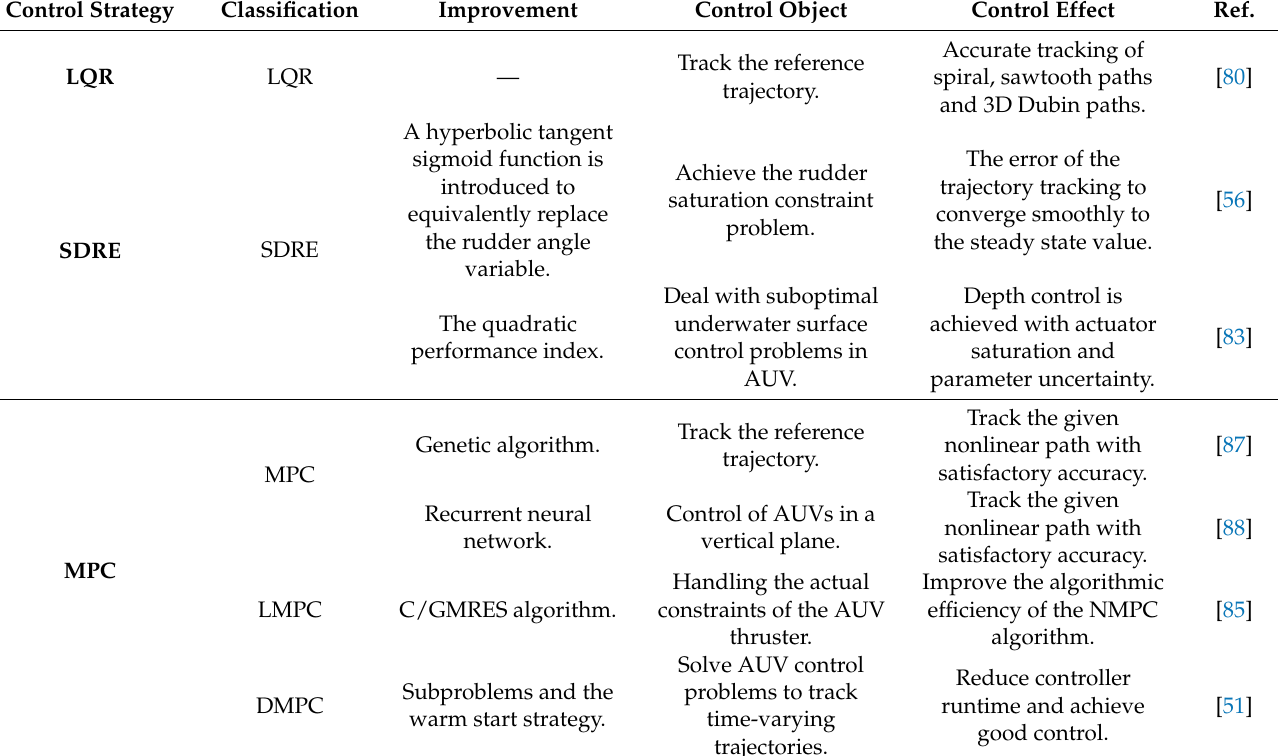
Table 3. Optimal control method in AUV trajectory